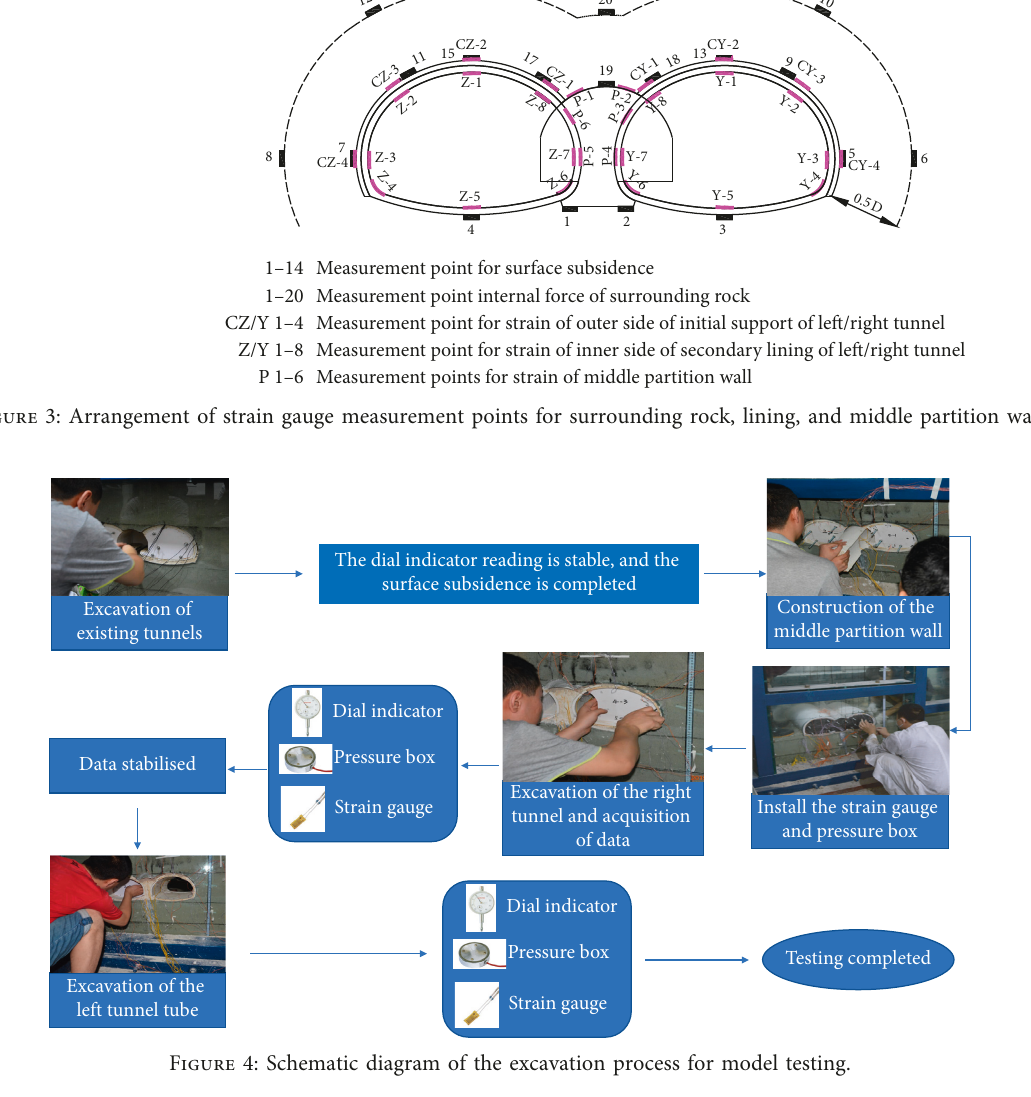
Figure 4: Schematic diagram of the excavation process for model